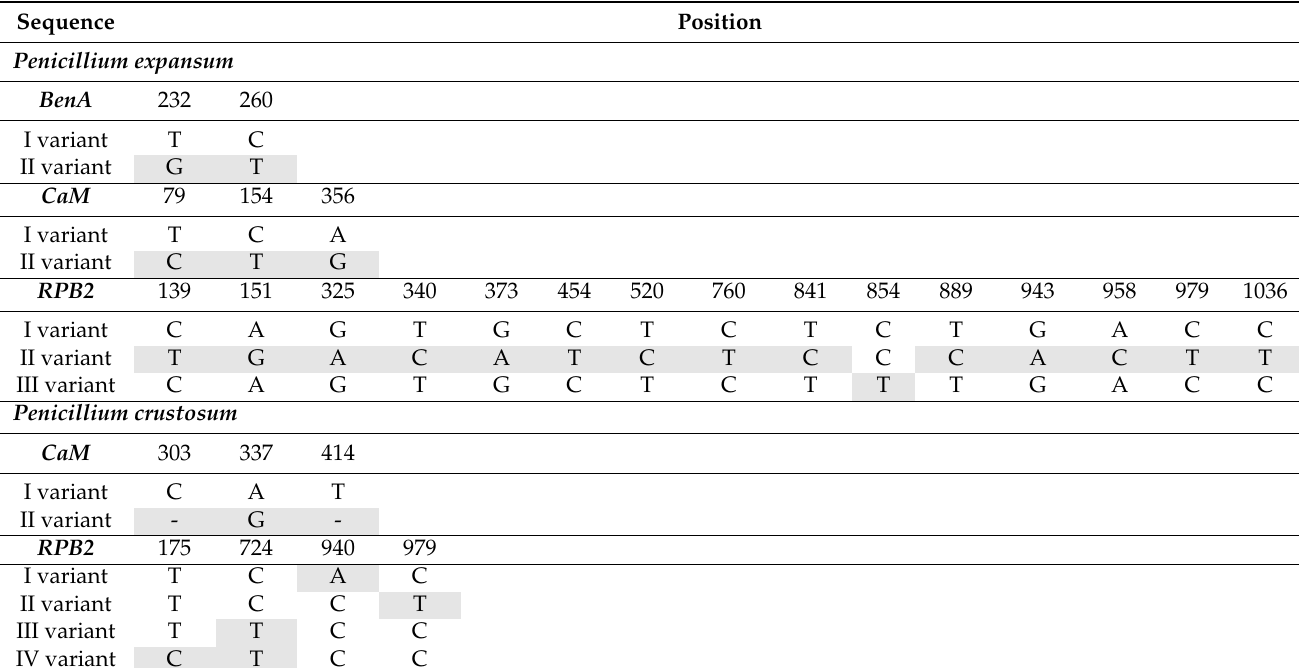
Table 2. Haplotype analysis of Penicillium expansum and P. crustosum